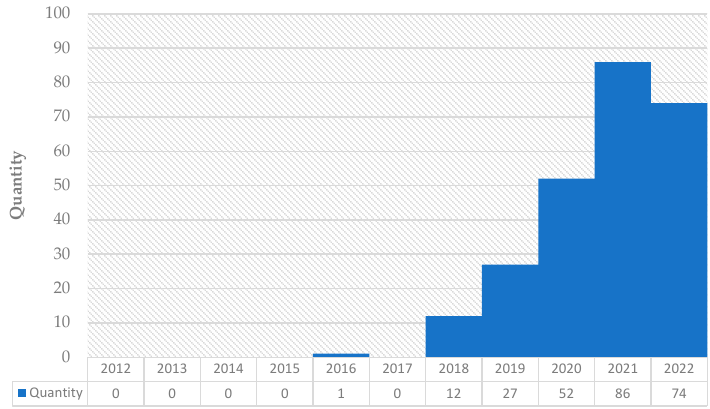
Information 2023 , 13 , x FOR PEER REVIEW Figure 2. The yearly number of articles released between 2012 and 2022. Figure 2. The yearly number of articles released between 2012 and 2022. The percentage of authors by nationality is presented in Figure 3. China has the most authors. India and the United States follow. This may suggest that the scientists of these crowded countries are working together, i.e., co-authoring numerous publications.